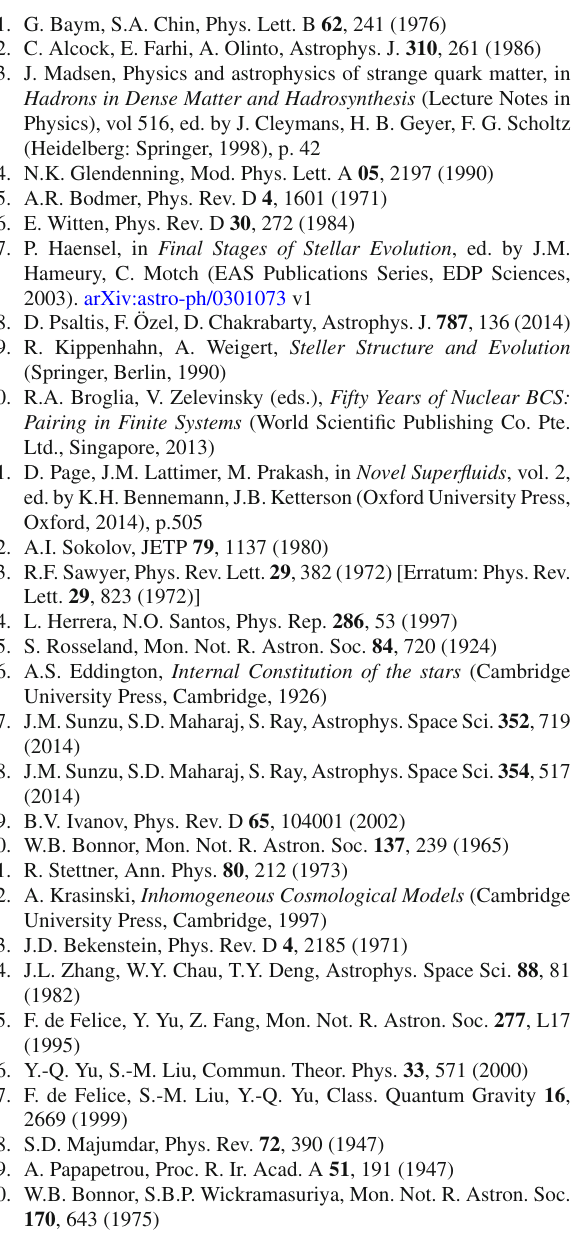
with space-time dimensions